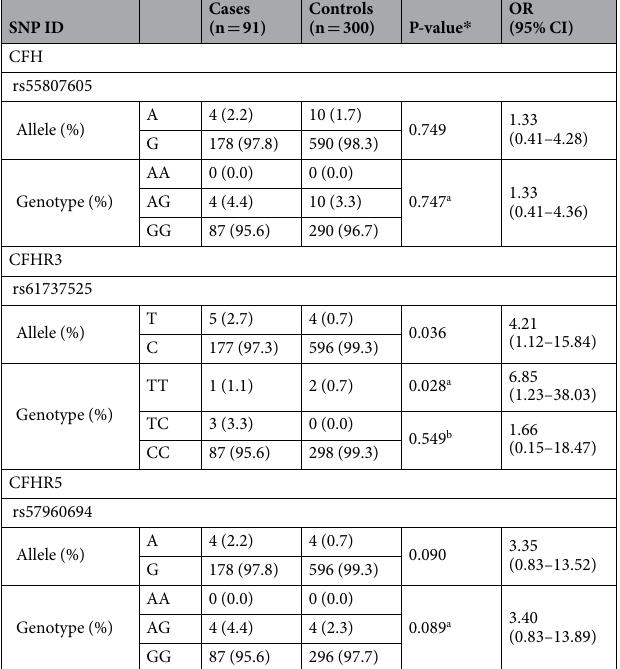
SNPs alleles Haplotype frequency